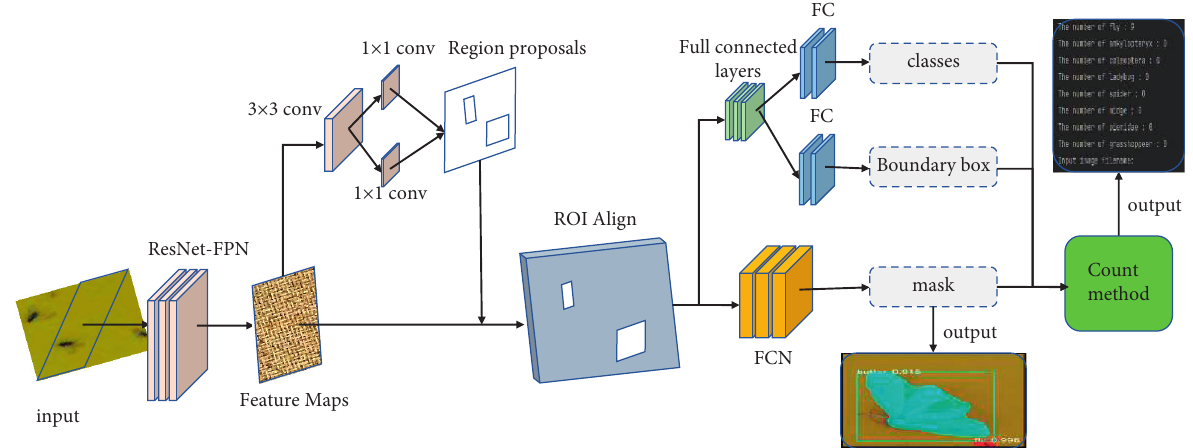
Figure 3: Mask R-CNN counting